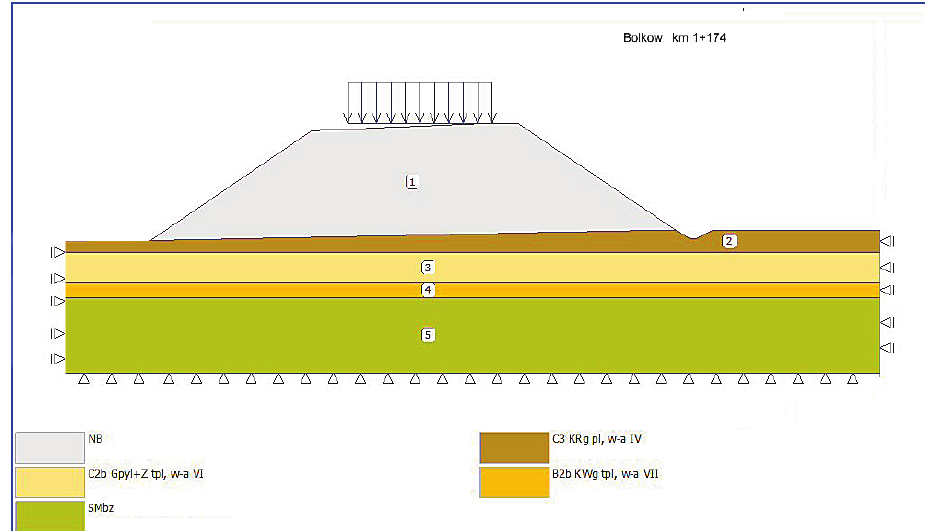
Figure 6: Computational scheme.